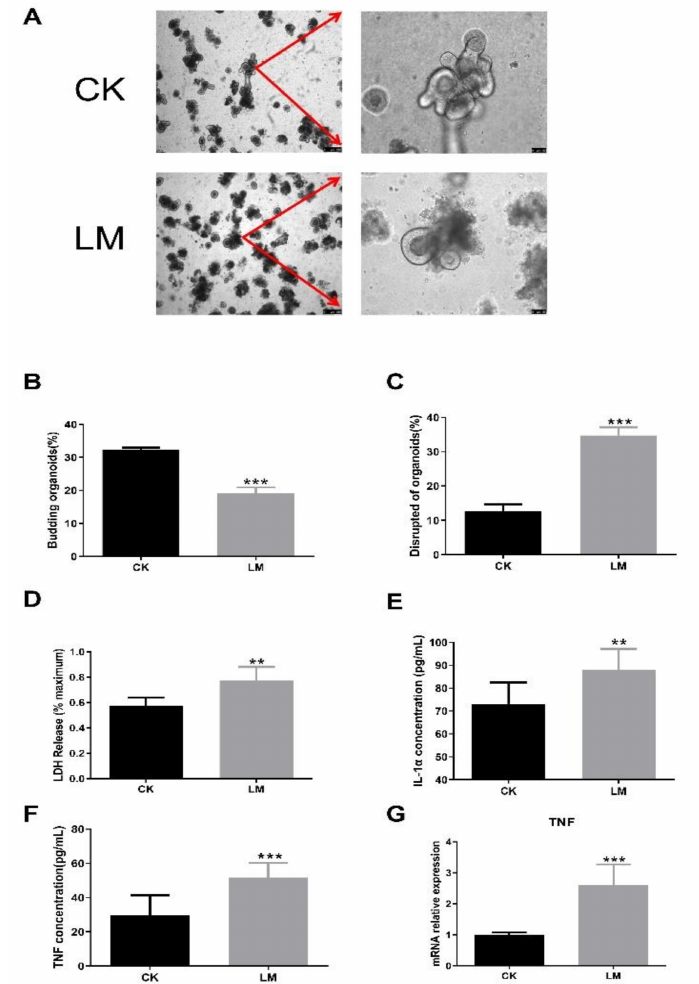
Figure 4. The damage of small intestinal organoids after L. monocytogenes infection. ( A ) The mor- phological changes in organoids after L. monocytogenes infection. ( B , C ) The budding percentage, and mortality, of organoids after L. monocytogenes infection. ( D ) LDH release in the supernatant. ( E , F ) The concentration of TNF and IL-1 β in the supernatant. ( G ) mRNA levels of TNF from organoids samples. ** p < 0.01, *** p <